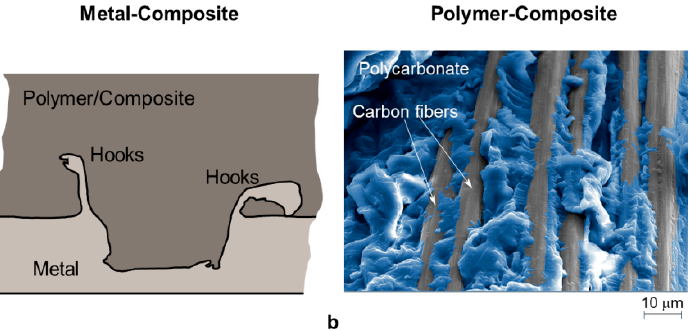
Figure 13. ( a ) Schematic of the cross-section of a metal-composite joint made by FSW and ( b ) fracture surface highlighting the adhesion of polycarbonate to the carbon fibers of a composite laminate (CFRP with epoxy matrix).